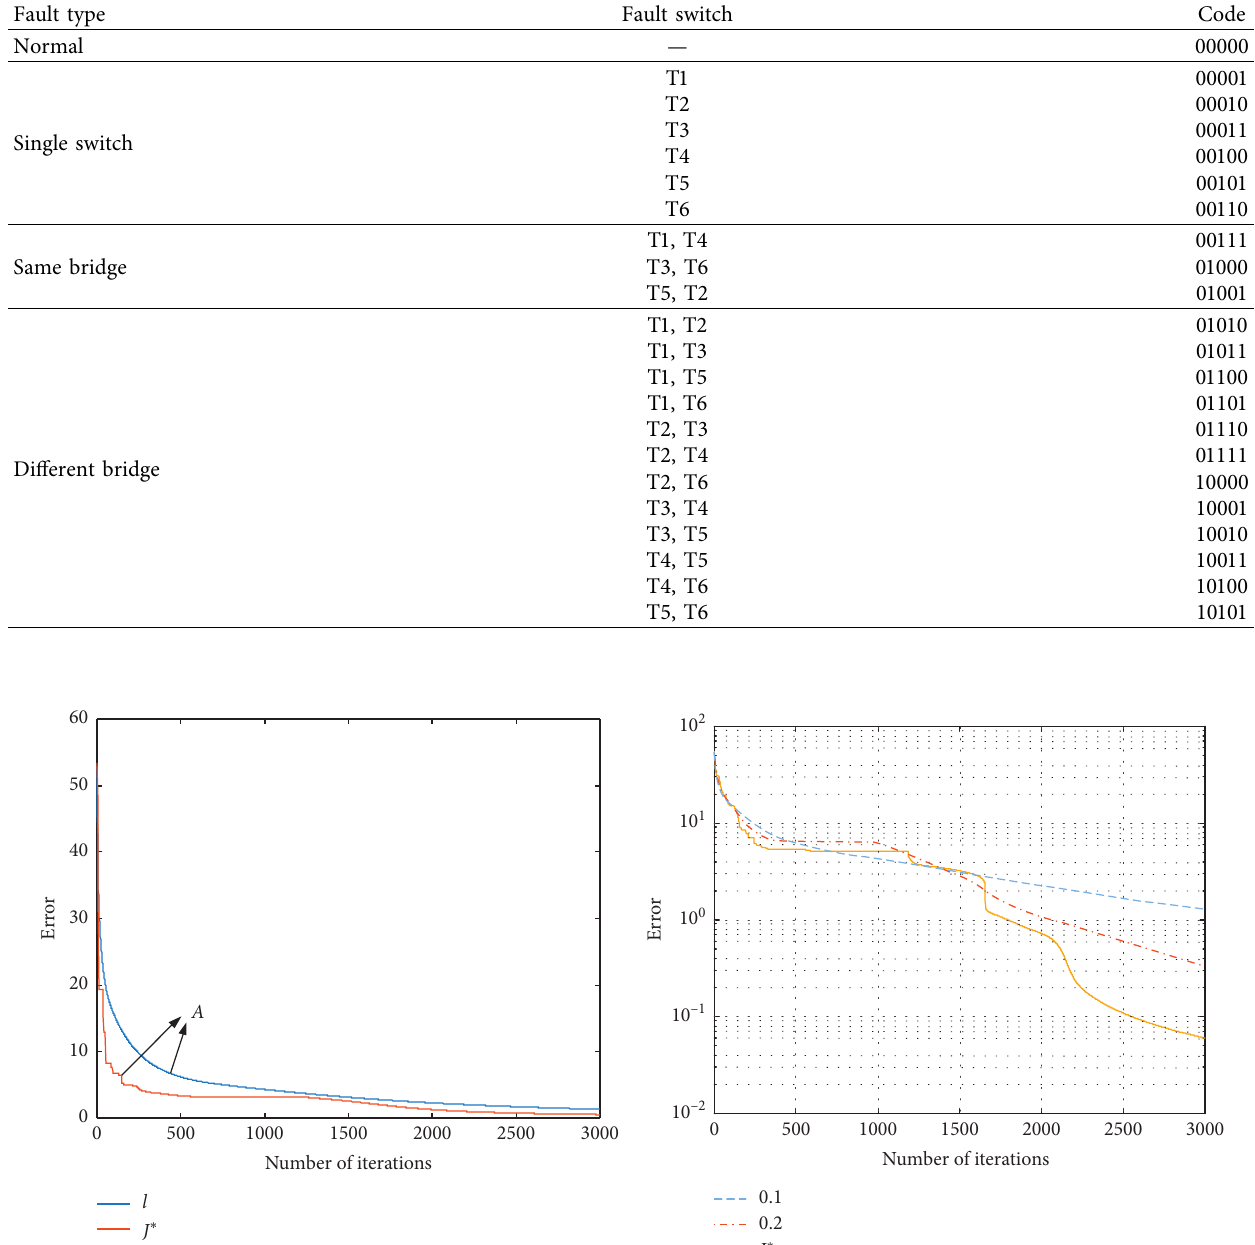
Table 1: Fault type code.